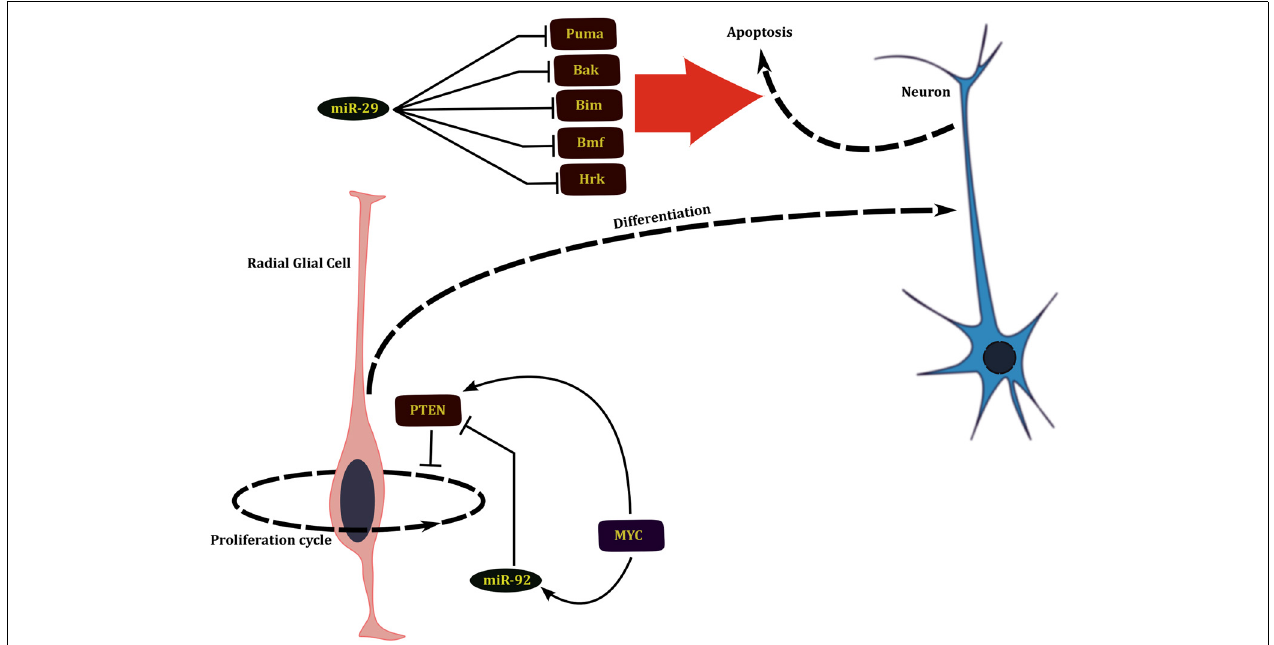
FIGURE 2 | miRNAs affect the development of nervous system by regulating proliferation of neural progenitors and apoptosis of young neurons.